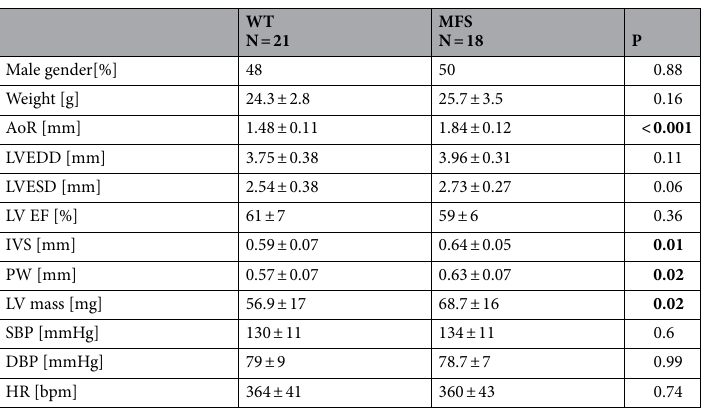
Table 1. Left ventricular and aortic remodeling in 4 mo-age mice. AoR aortic root diameter, LVEDD left ventricular end-diastolic diameter, LVESD left ventricular end-systolic diameter, LVEF left ventricular ejection fraction, IVS interventricular septum thickness, PW posterior wall thickness, SBP systolic blood pressure, DBP diastolic blood pressure, HR heart rate. Continuous variables data is presented as mean ± SD. Independent two- sample t-test for normally distributed continuous variables and the Mann–Whitney U test for non-parametric distribution. Categorical variable (male gender) is presented as percentage (%) and compared using χ 2 test. P<0.05, in bold, denote statistical